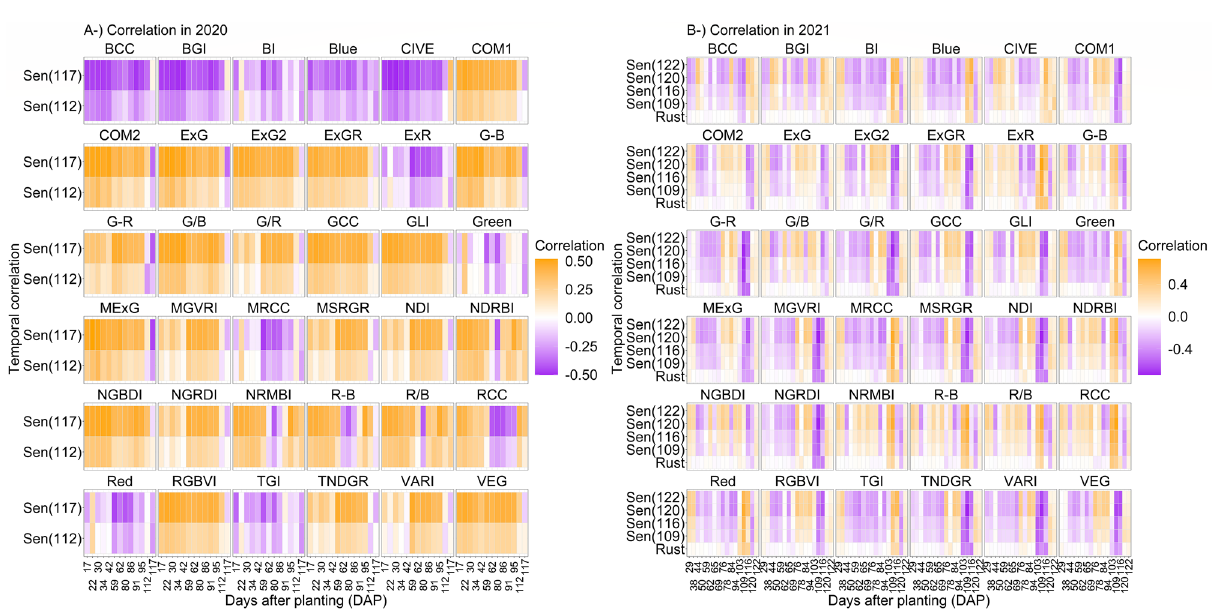
Figure 8. Temporal correlations between predicted variables (two and four senescence scores in 2020 and 2021 respectively, and rust in 2021) and temporal phenotype of each VI belonging to 2020 and 2021 phenotype data. ( A ) and ( B ) represent 2020 and 2021 temporal correlations,